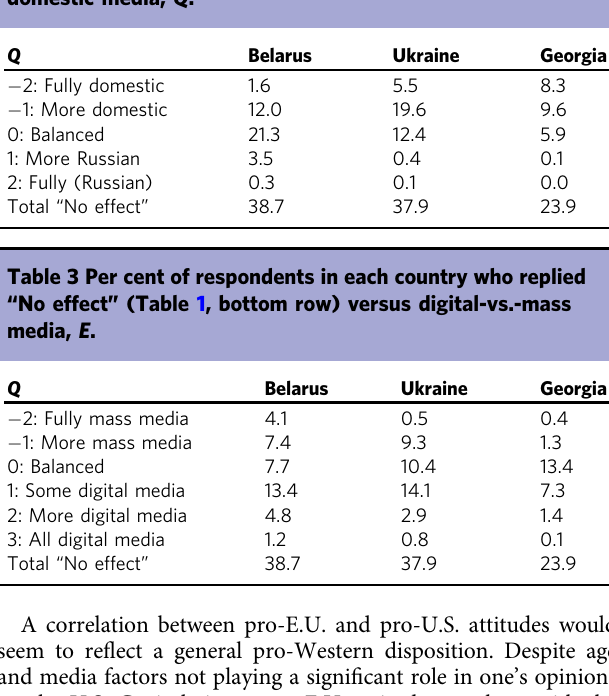
Table 2 Per cent of respondents in each country who replied “ No effect, ” (Table 1, bottom row) versus Russian-vs.- domestic media, Q